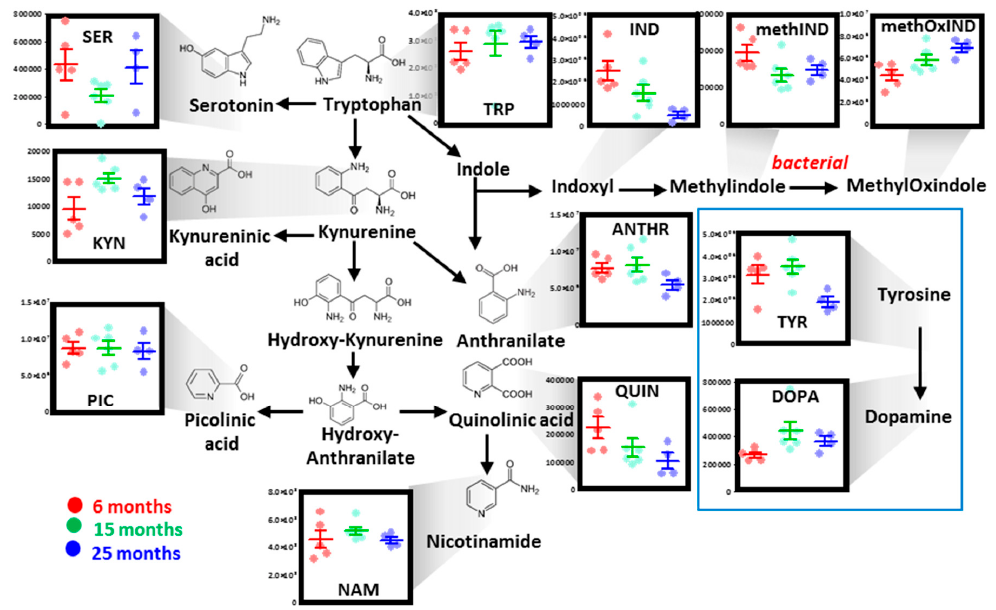
Figure 4. Tryptophan metabolism in mouse RBCs as a function of aging. Dots represent distinct